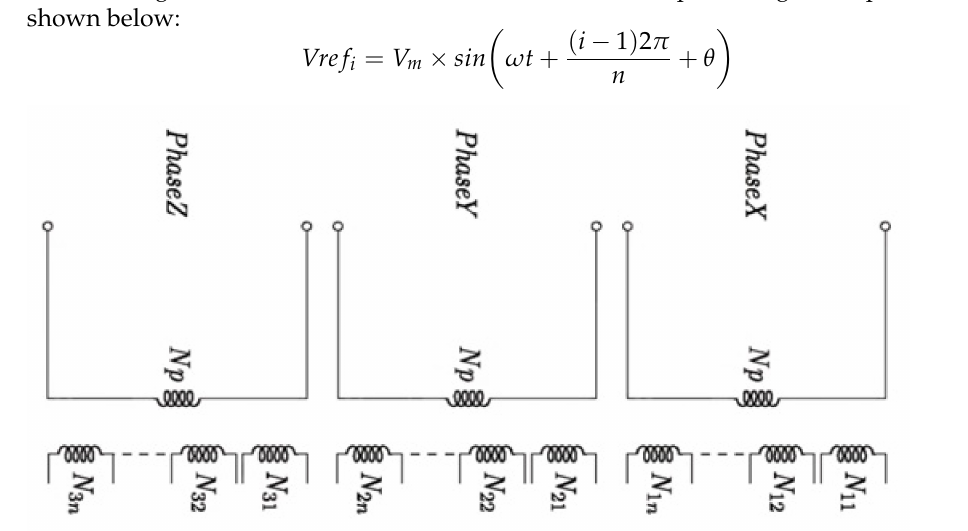
Figure 3. Schematic diagram of three-phase to n -phase